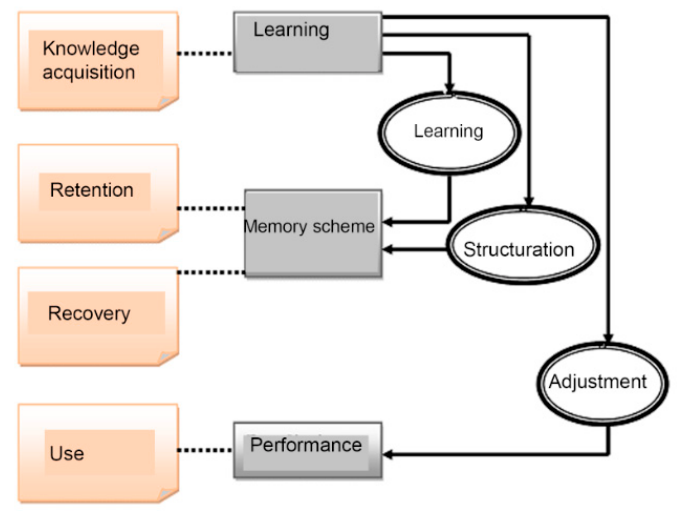
Figure 3. Knowledge understanding framework in the maintenance activity.